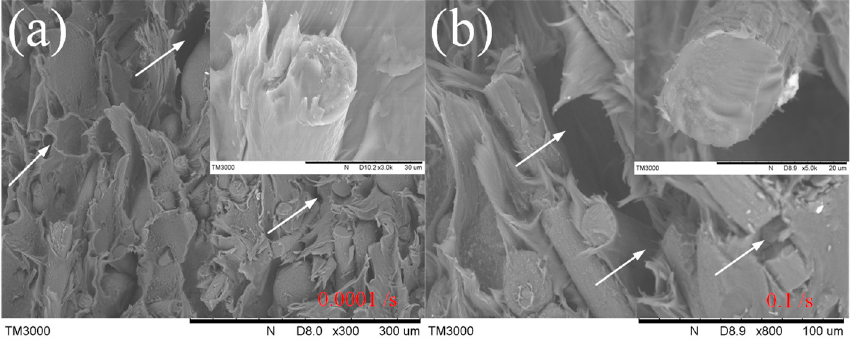
Figure 12. Fracture surfaces of CF/PA12 under different strain rates: ( a ) 10 -4 s -1 ; ( b ) 10 -1 s -1 .